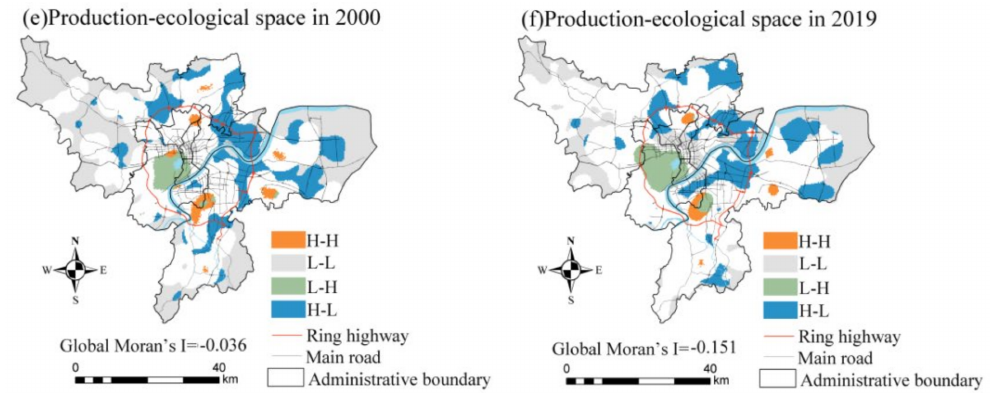
Figure 6. Spatial autocorrelation analysis for production–living–ecological spaces in Hangzhou in 2010 and